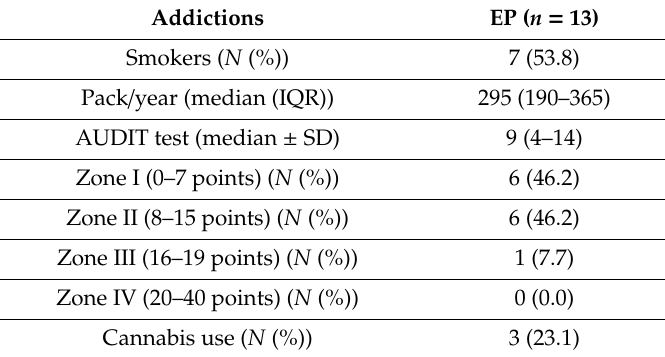
Table 2. Prevalence of drug abuses in our cohort.